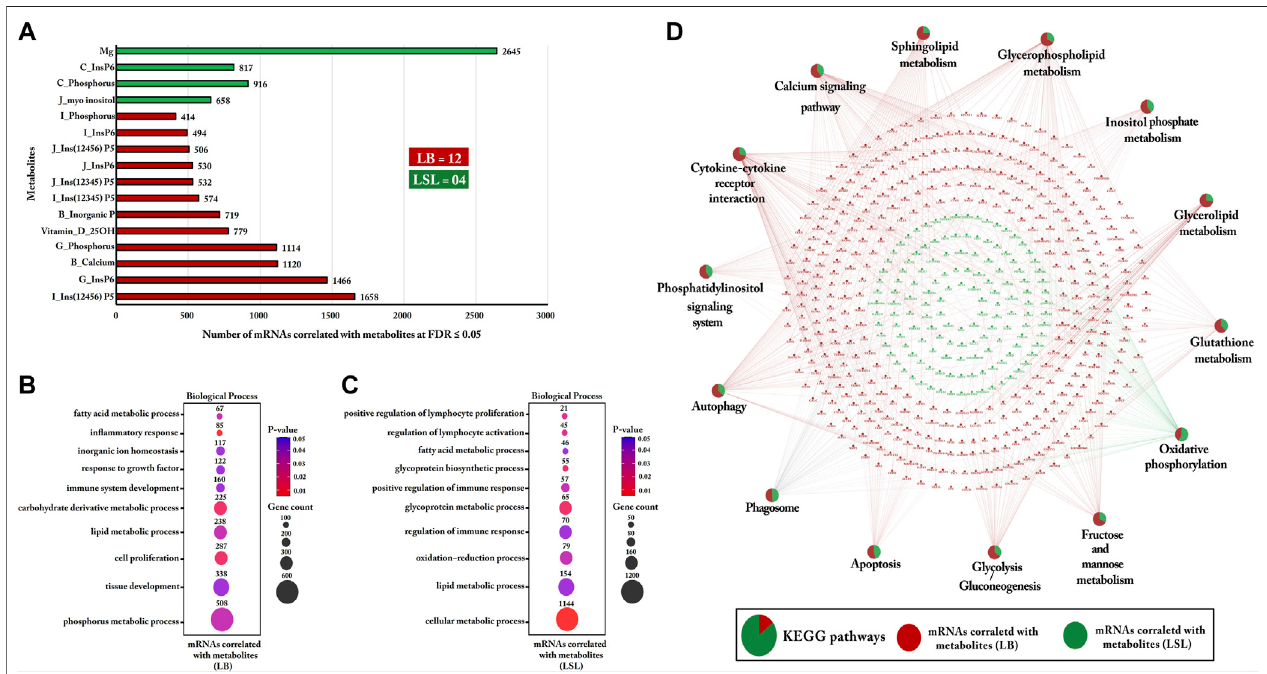
FIGURE 10 | Gene Ontology and KEGG pathways enrichment analysis of mRNAs correlated with blood/digesta parameters within LB and LSL. (A) The bar chart indicates the number ofmRNAs correlated with blood/digesta parameters at FDR ≤ 5% within LB and LSL (r ≥ 0.5). The green bar shows the blood/digesta parameters that are more abundant in LSL, while the red bar depicts blood/digesta parameters that are more abundant in LB. (B) The transcripts correlated with blood/digesta parameters in LB were subjected to DAVID (version 6.8) for Gene Ontology (biological processes) enrichment analysis. (C) Gene Ontology (biological processes) enrichmentanalysisoftranscriptscorrelatedwithblood/digestaparametersinLSL.Thedotsizerepresentsthenumberoftranscriptsinvolvedineachbiologicalprocess, while the dot ’ s color indicates the p -value. (D) KEGG pathway enrichment analysis of mRNAs correlated with blood/digesta parameters within LB and LSL. The pie chartsindicatethestrain-speci fi cproportionsofmRNAscorrelatedwithblood/digestaparameterstotheKEGGpathways.TheredellipseshowsmRNAscorrelatedwith blood/digesta parameters in LB, and the green ellipse depicts mRNAs correlated with blood/digesta parameters in LSL. KEGG pathways and biological processes with p ≤ 0.05 were considered signi fi